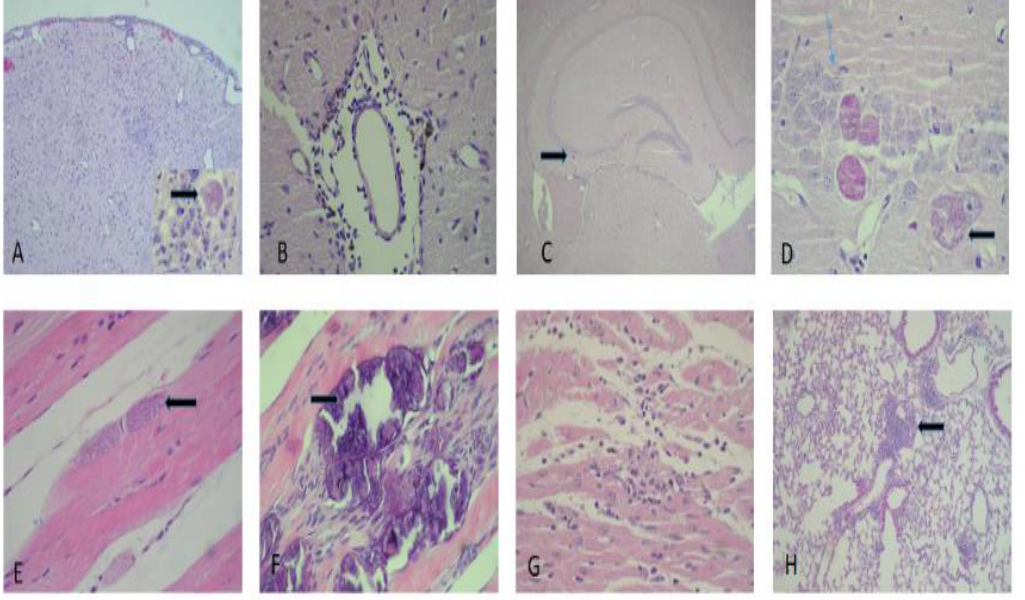
Figure 9. Histological cuts from brain cortex, skeletal muscle and lung in the chronic-infected group. ( A ) Brain cortex with meningitis, gliosis (100 × ) and a cyst (1000 × ). ( B ) Lymphocytic perivascular inflammation accompanied by an infiltrate (400 × ). ( C ) Hippocampus with cysts (100 × ). ( D ) A cyst illustrating a rejection of the neuronal nucleus (thick blue arrow; 1000 × ). ( E ) Toxoplasma cysts in the skeletal muscle sarcoplasm (400 × ). ( F ) Dystrophic calcification in the sarcoplasm due to cyst destruction. Note adjacent tissue regeneration (1000 × ). ( G ) Moderate myocarditis (400 × ). ( H ) Inflammatory pulmonary infiltrate; predominantly peribronchiolar (100 × ). The arrows indicate Toxoplasma cysts. Table 2. Histological findings in the C57BL/6 mice infected with the ME-49 strain of Toxoplasma gondii . Pathological